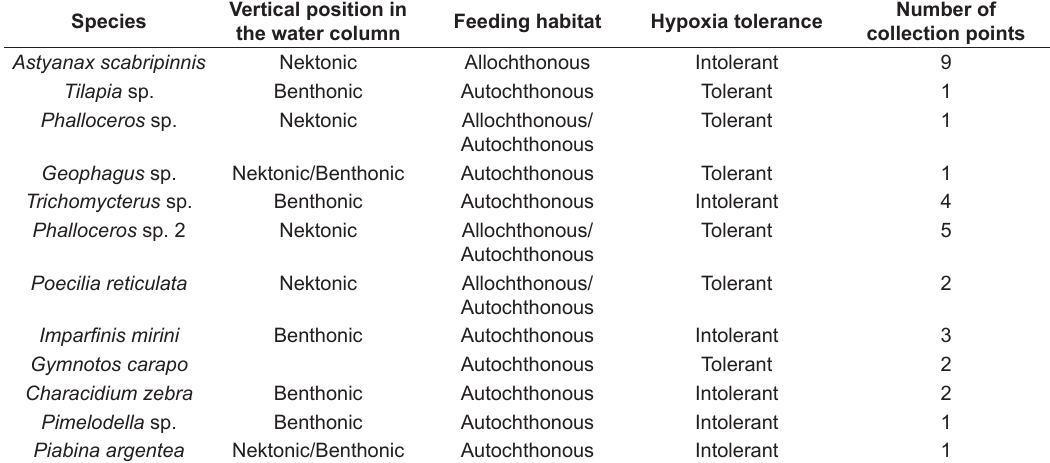
Table 2. Fish species collected from 13 headwaters distributed among four rivers, Cabeça, Corumbataí, Passa Cinco